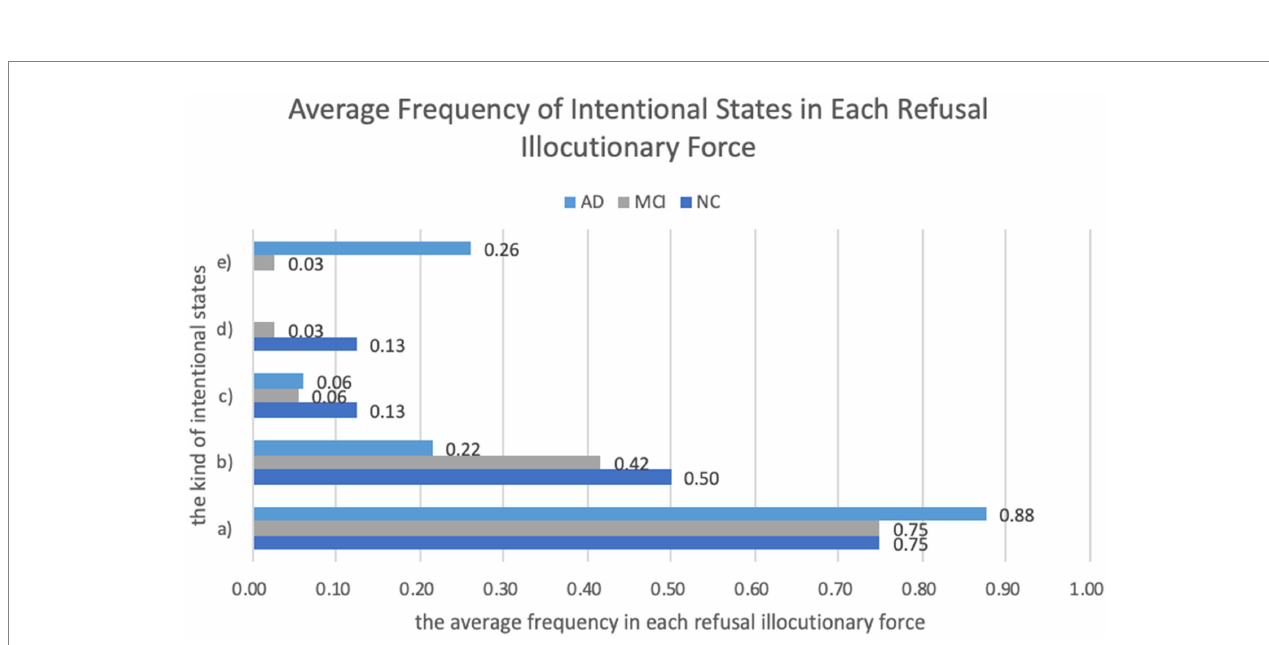
FIGURE 4 Average frequency of different types of intentional states in each